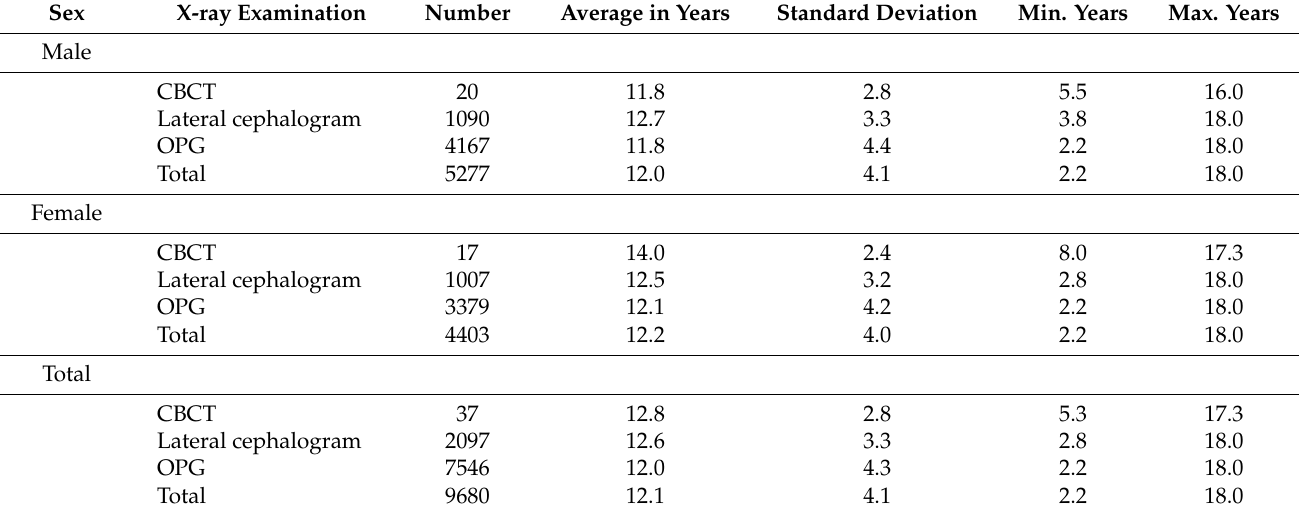
Table 3. Type of dental X-ray diagnosis in relation to patient age.